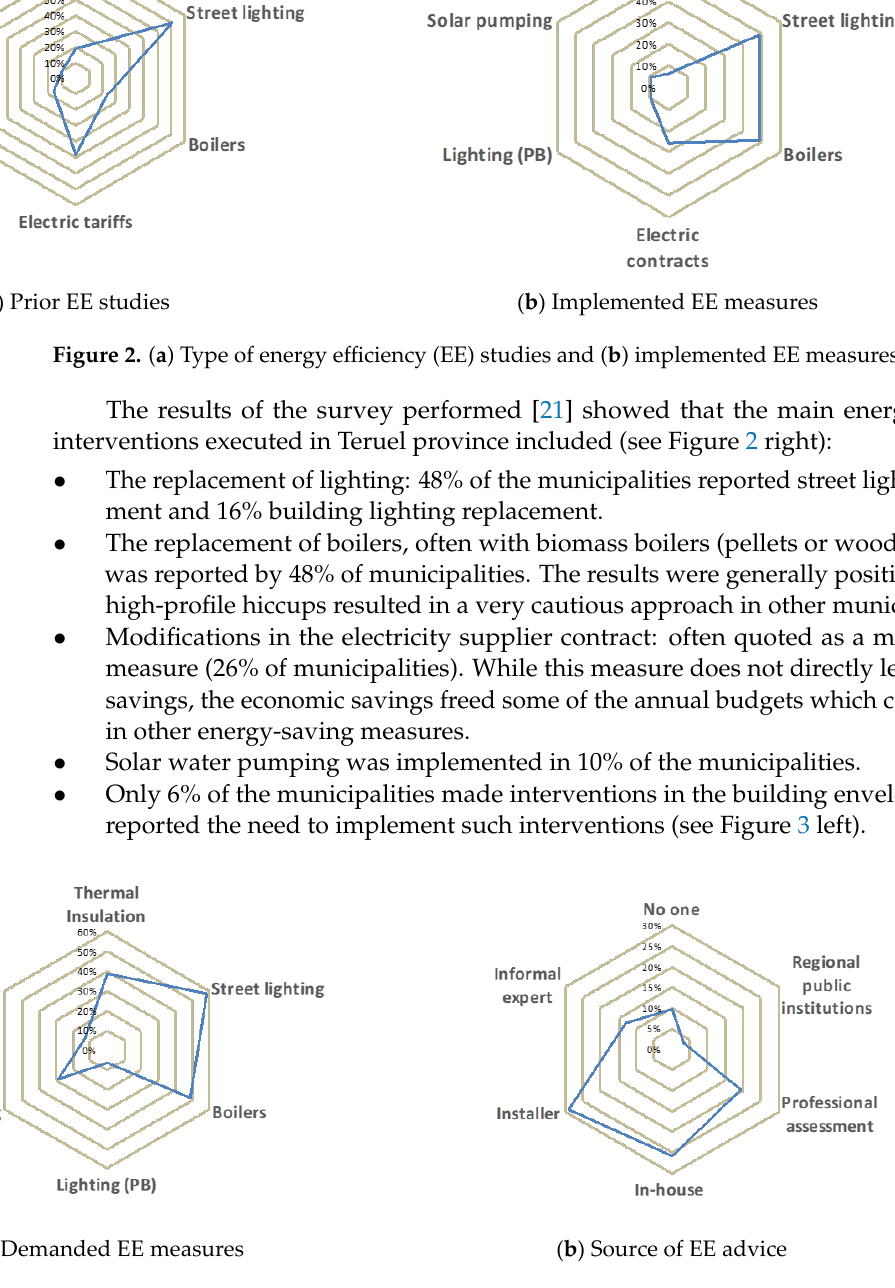
Figure 3. ( a ) Type of energy efficiency measures demanded by the municipalities and ( b ) the source of advice for the energy efficiency